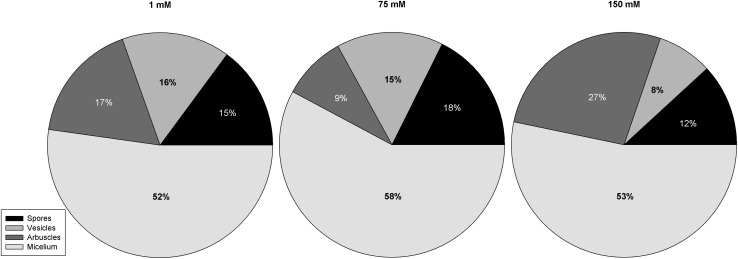
AM fungi structures percentages to the total colonization of each salinity treatment.